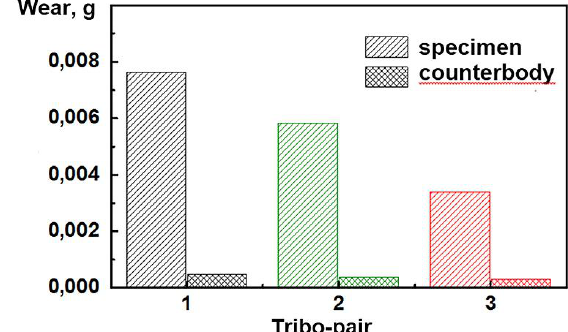
Fig.4. Wear of the friction pairs “steel - CEC Ni-B”, load 280 N. CEC Ni-B: ( 1 ) – without thermal treatment, after vacuum annealing at 300  С ( 2 ), and 450  С ( 3 )